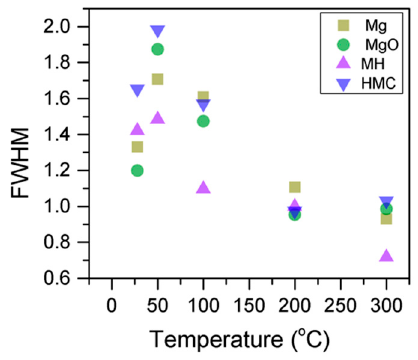
Figure 5. Evolution of the Mg2p FWHM as the temperature increases.